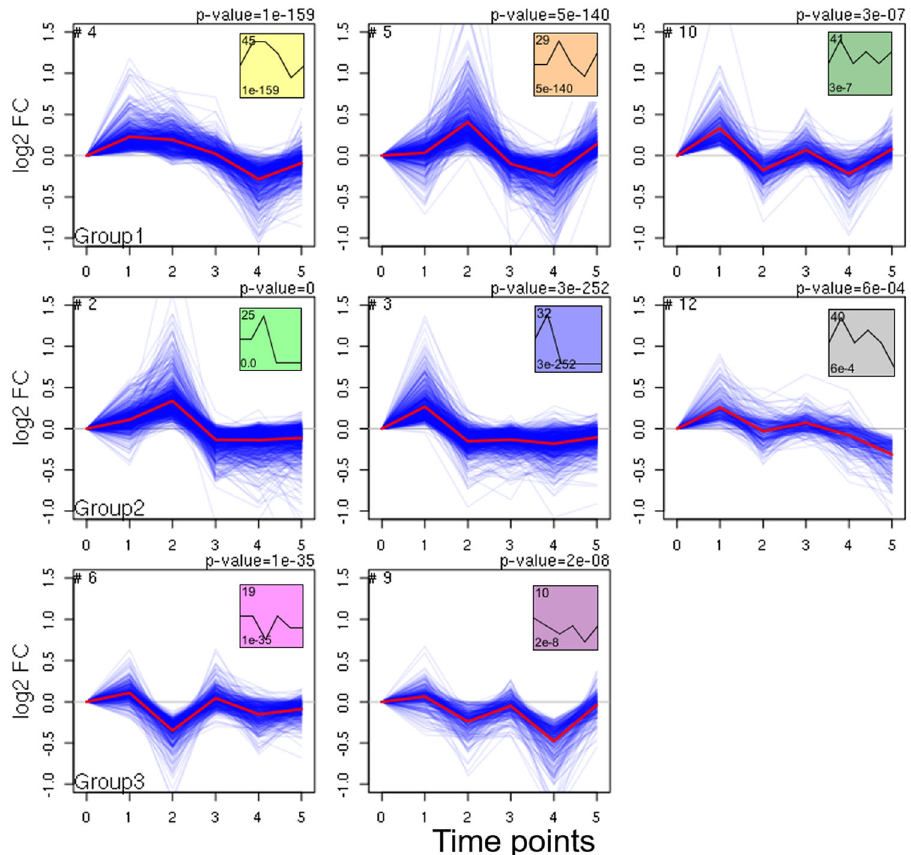
Fig. 3 The signi fi cant clusters are divided into three groups based on the temporal change patterns and enriched pathways in each cluster. Inside each set (in the box), the cluster number is displayed in the left-hand corner and the corresponding pro fi le de fi ned by the STEM software is displayed in the right-hand corner. p value is presented on the top of each cluster. p value is determined by STEM software based on a binomial distribution by comparing the actual number of genes assigned to the group against the expected number of genes. After insulin treatment, gene expression went up in group 1, went up initially but decreased in group 2, and went down in group